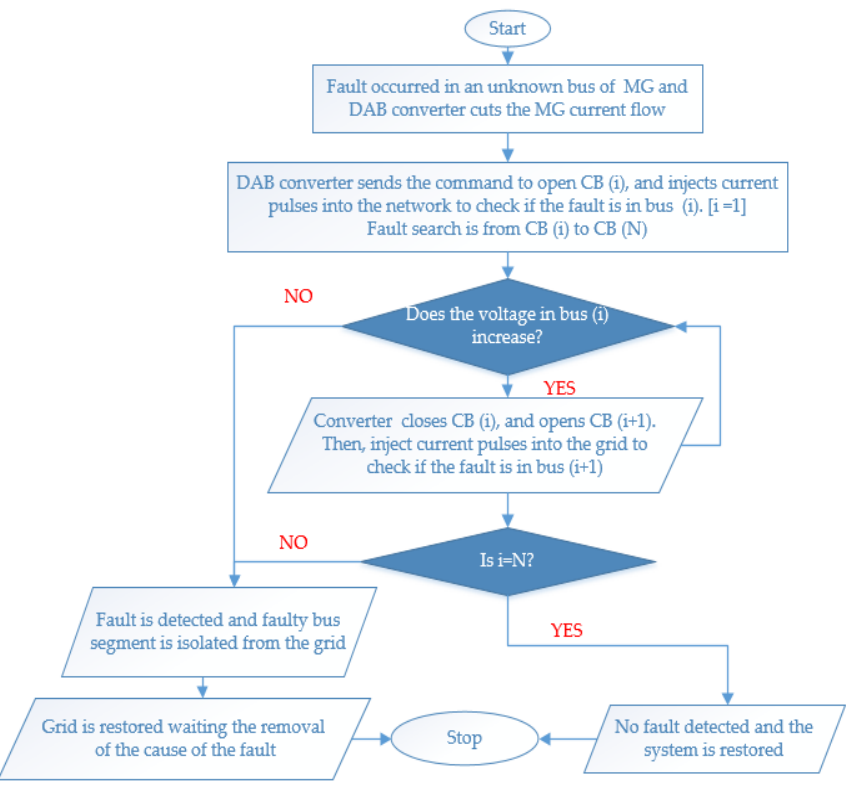
Figure 5. Fault detection using bus fault search by opening and closing individual CBs.